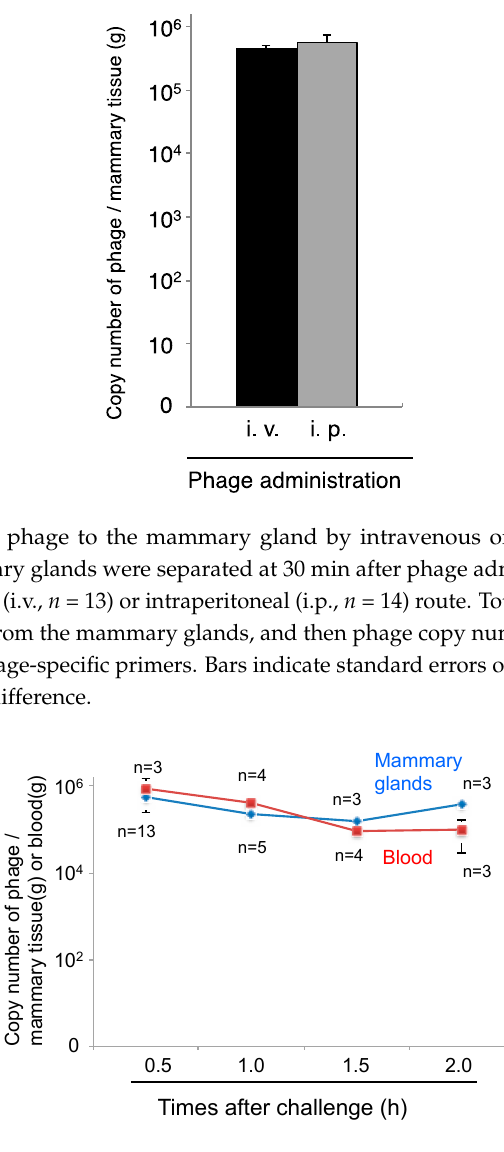
Figure 4. Kinetic analysis of phage distribution into the mammary glands through intraperitoneal administration. Mammary glands and blood were separated at 0.5 to 2.0 h after phage administration only (4 × 10 7 PFU) through intraperitoneal route. Total DNA containing phage and host cells-derived DNA was purified from the mammary glands and blood and then phage copy numbers were determined by real-time PCR using phage-specific primers. Bars indicate standard errors of the means.